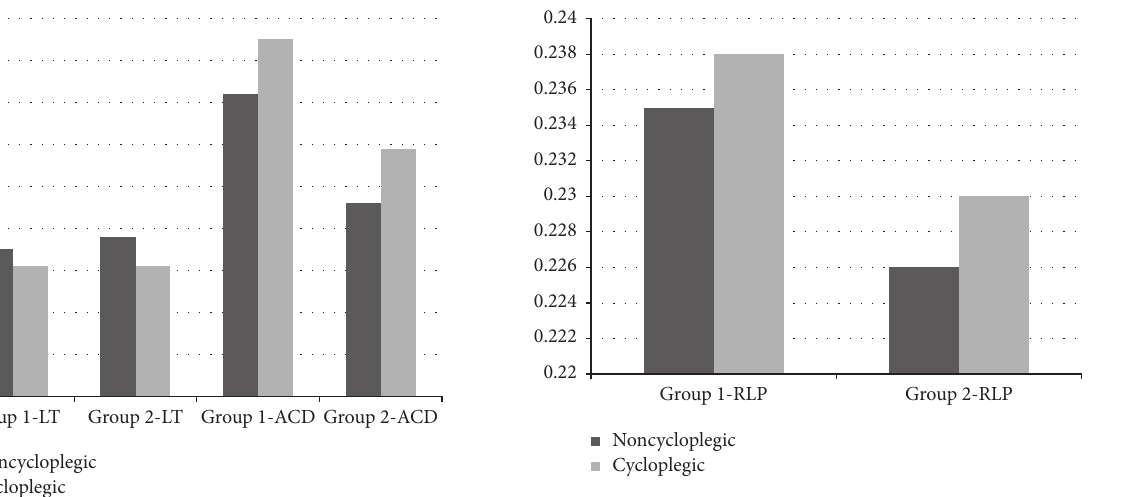
Figure 2: LT and ACD changes with cycloplegia. LT: lens thickness, ACD: anterior chamber depth.